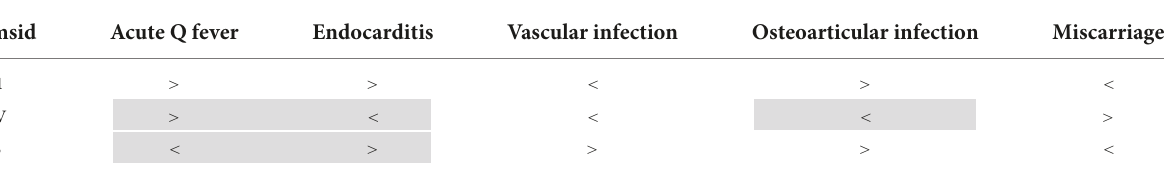
TABLE 3 Significance by cell.